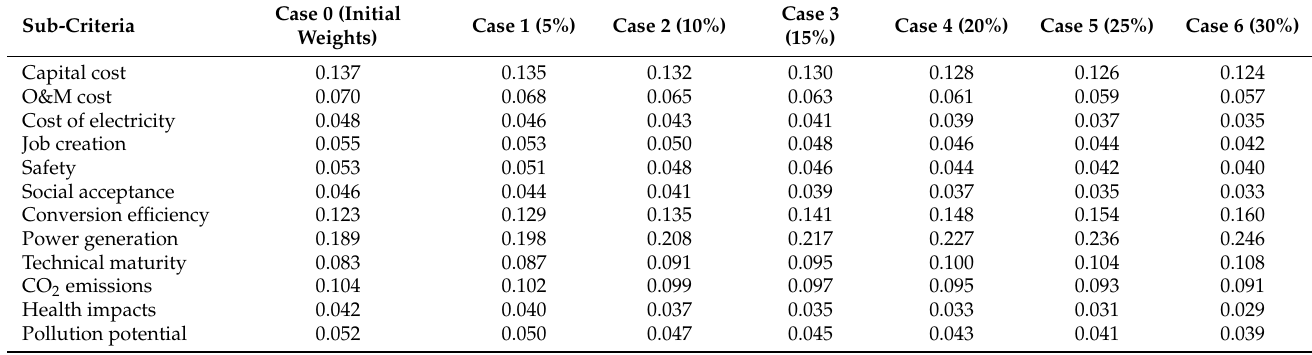
Table 12. Initial and modified criteria weights after increasing the technical criteria weights by 5% to